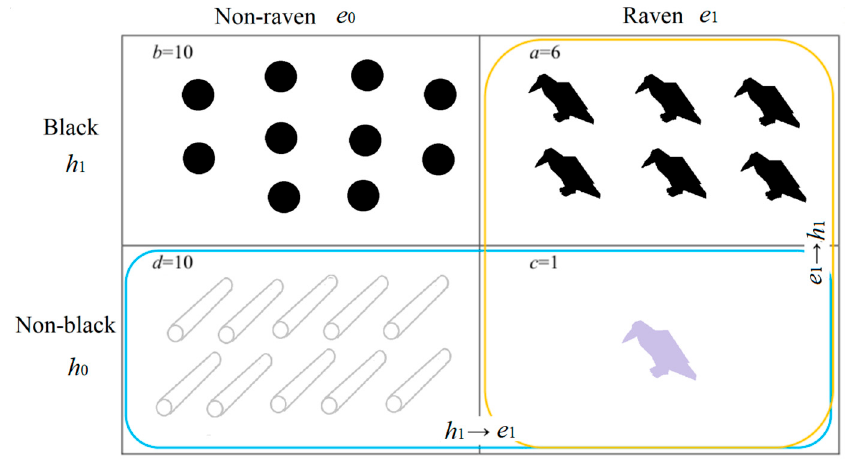
Figure 9. Using a sample to examine di ff erent confirmation measures for the Raven Paradox. Source: author.